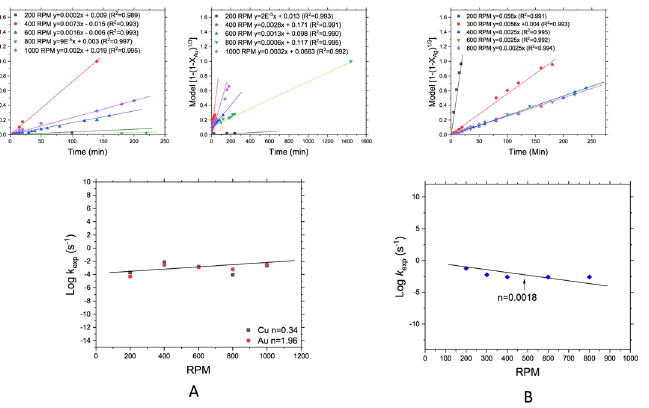
Figure 7. Leaching of ( A ) Au and Cu from WEEE, and ( B ) Ag from MW: Effect of stirring rate.